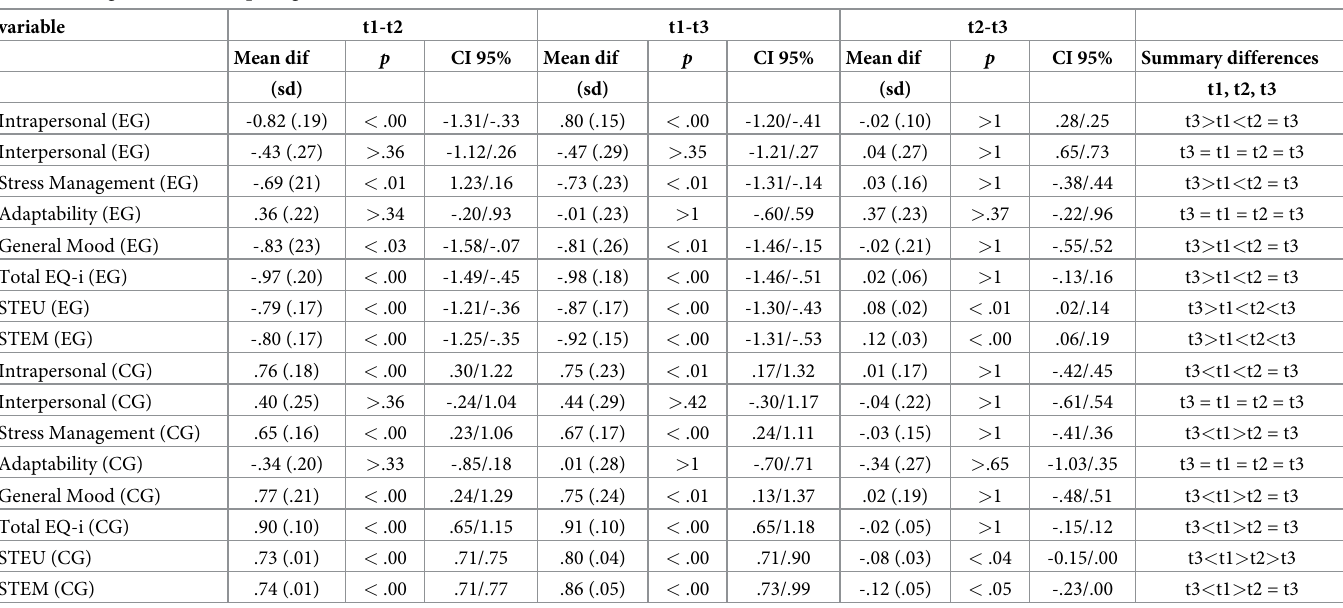
Table 3. Marginal means comparing t1-t2, t1-t3, and t2-t3.